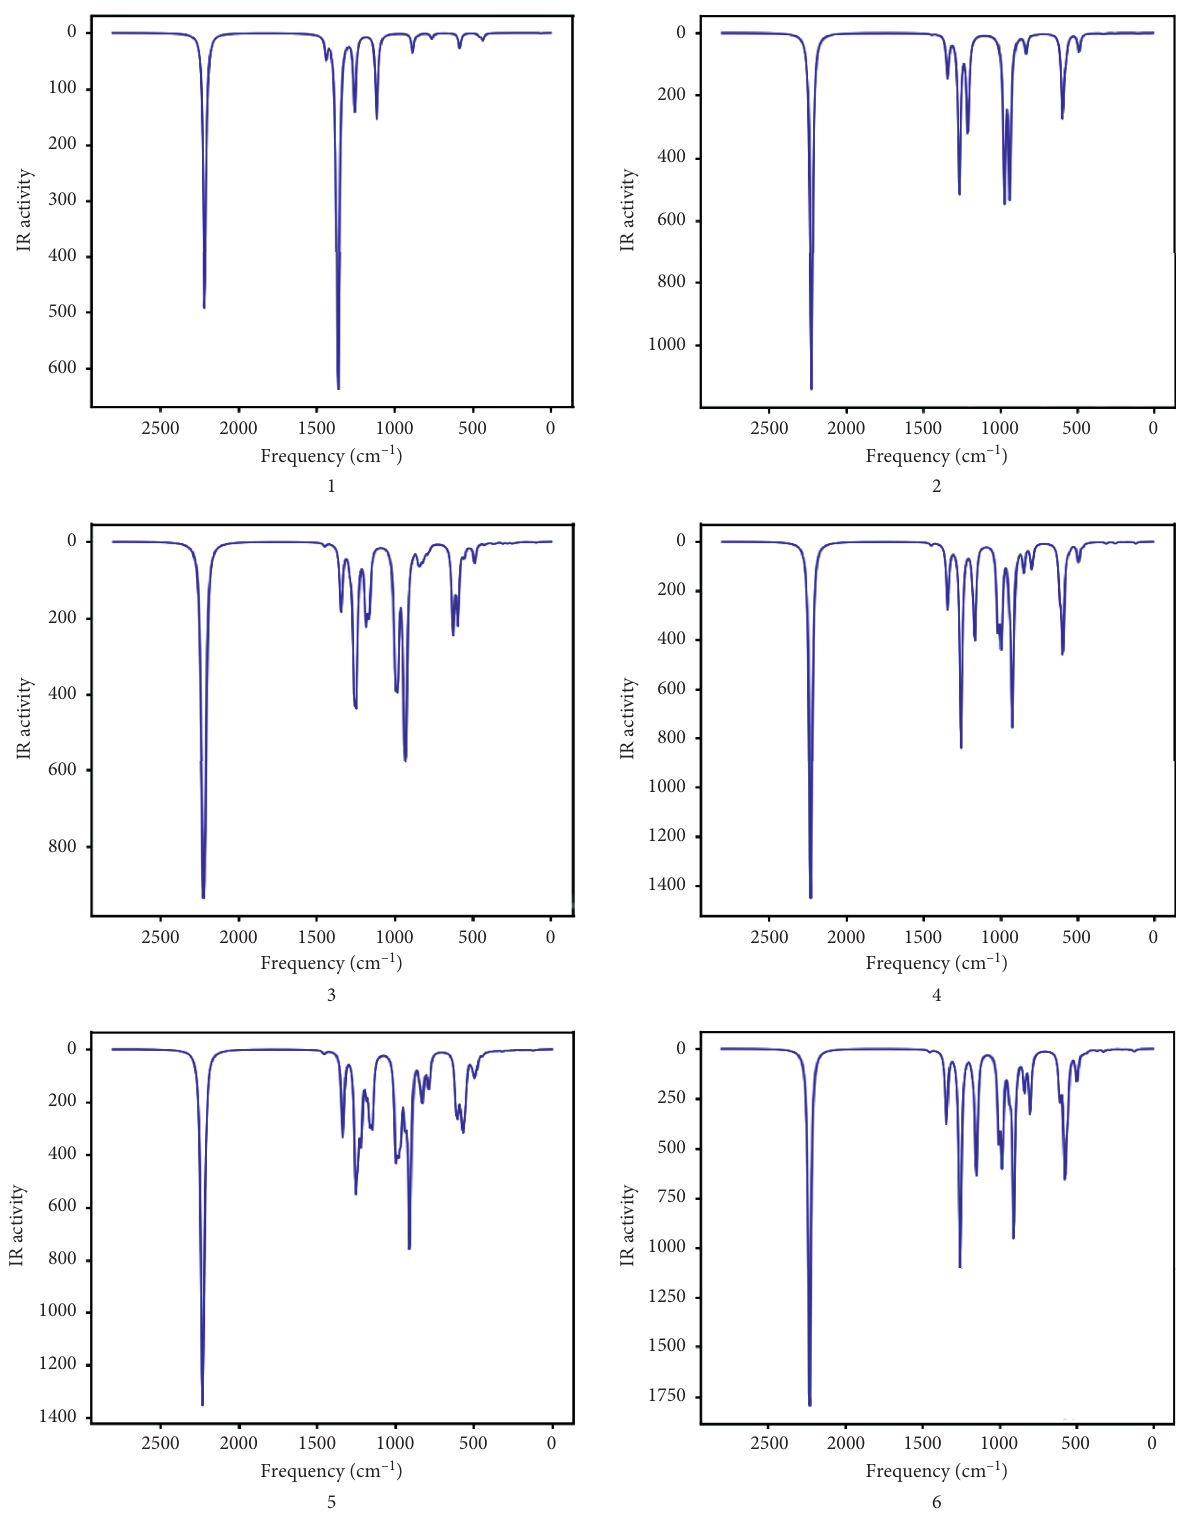
Figure 3: IR spectra of the asymmetric clusters (CH